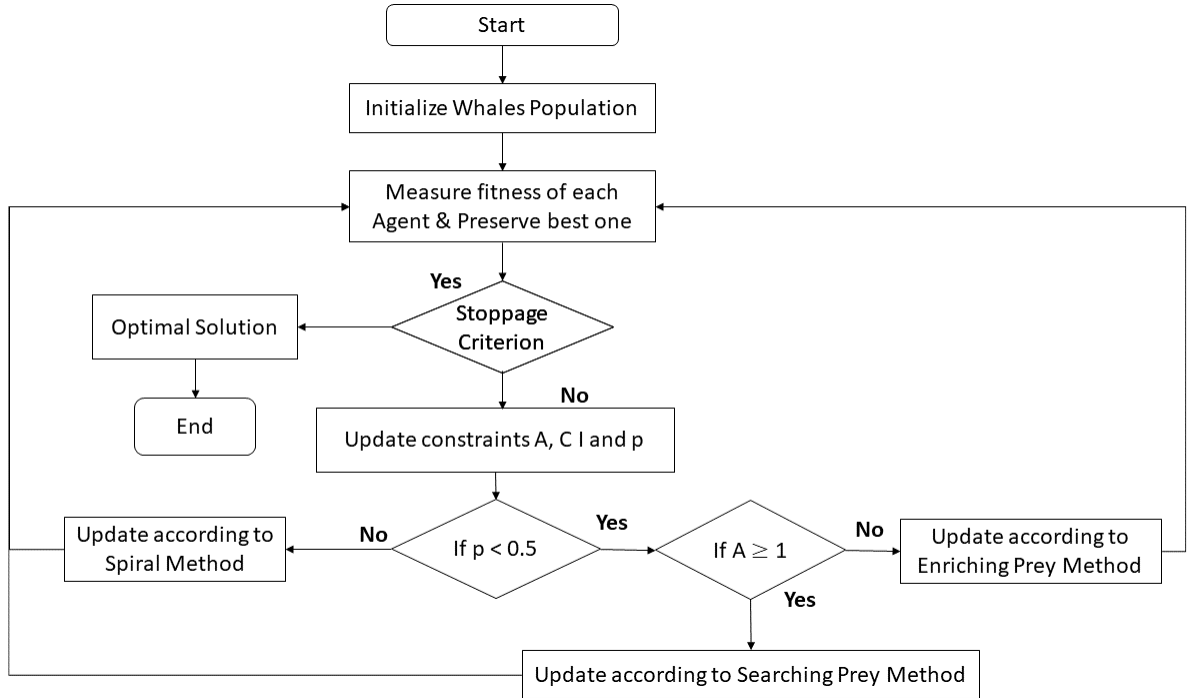
Figure 4. Flowchart of MWOA.